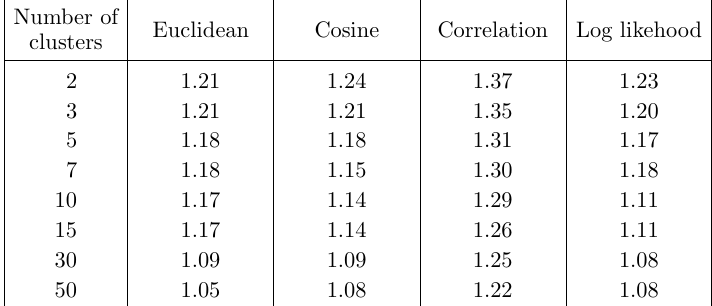
Evaluation ( RMSE ) of memory-based collaborative